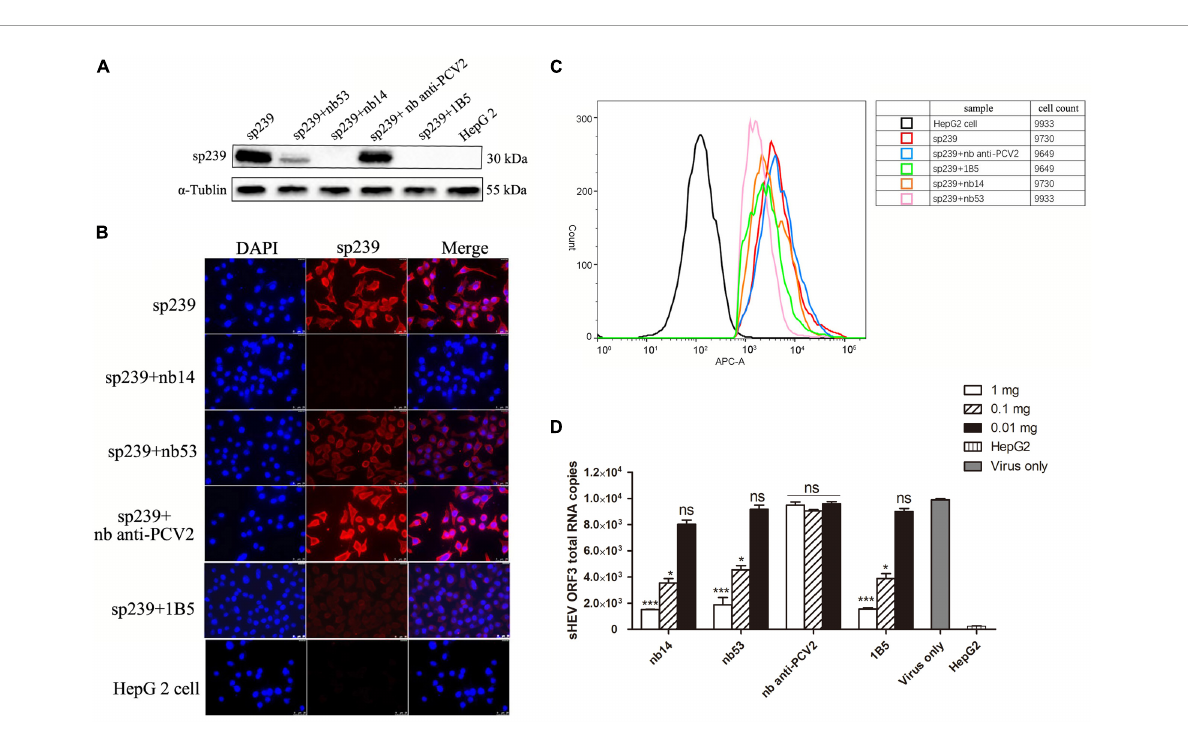
FIGURE3 Nanobodies blocking sp239 absorption or natural swine HEV particle infection of HepG2 cells. Nanobodies blocking sp239 attachment to HepG2 cells followed by detection with Western blotting (A) , immunofluorescence focus assay (IFA) (B) , and flow cytometry neutralization (FCM) (C) assays. (D) Nanobodies blocking swine HEV infection of HepG2 cells by real-time RT-PCR. The nb anti-PCV2 and the MAb 1B5 served as negative and positive controls, respectively. Data are the mean ± SD of results based on triplicate experiments. P -values were calculated with student’s t -test. * P < 0.05; ** P < 0.01; *** P < 0.001; ns, not significant.